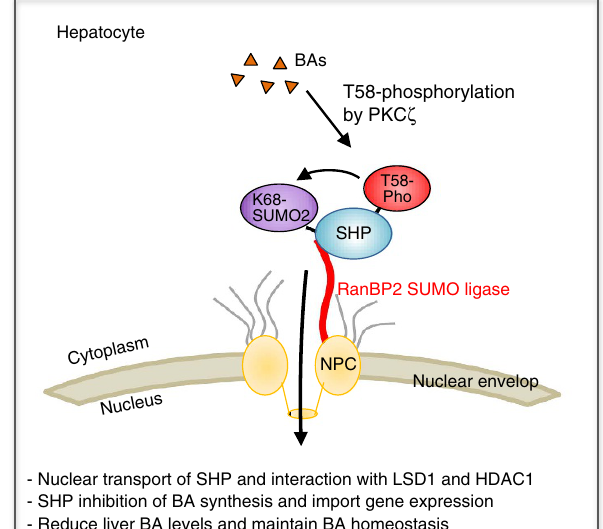
Figure 9 | Model. In response to elevated hepatic BA levels, interaction between RanBP2 and SHP is increased. RanBP2, then, mediates SUMO2 modification of SHP at K68, which facilitates the nuclear transport of SHP and increased SHP interaction with histone-modifying enzymes, LSD1 and HDAC1, resulting in feedback repression of BA synthesis and import transport that is critical for reducing liver BA levels and maintaining BA homoeostasis. Phosphorylation of SHP at Thr-58 (Thr-55 in human SHP) by PKC z likely acts upstream of the RanBP2-mediated SUMOylation of